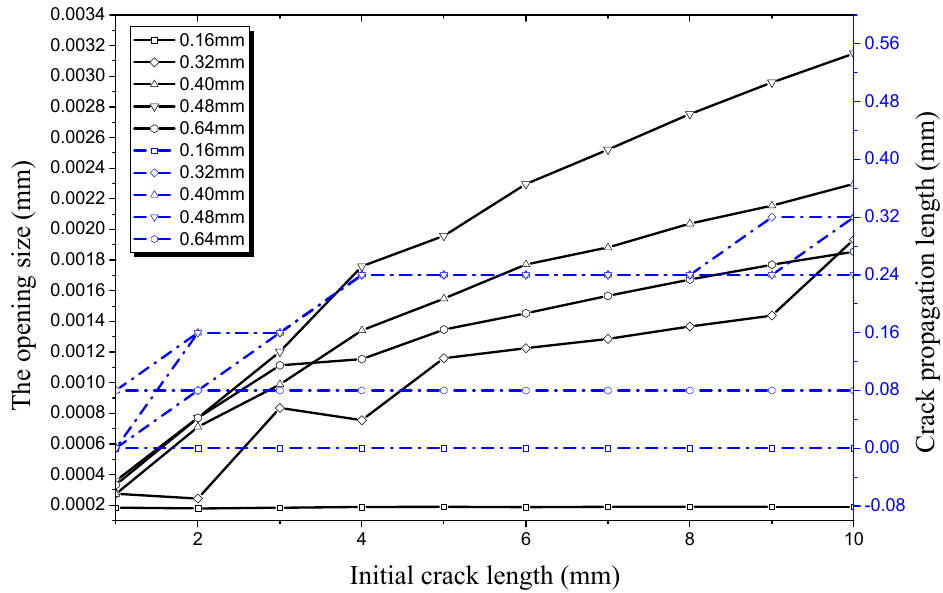
Figure 24. Relationship between radial crack propagation length and initial crack length on the inner surface, and relationship between radial opening size and initial crack length on the inner surface, both under an internal pressure of 28 MPa.